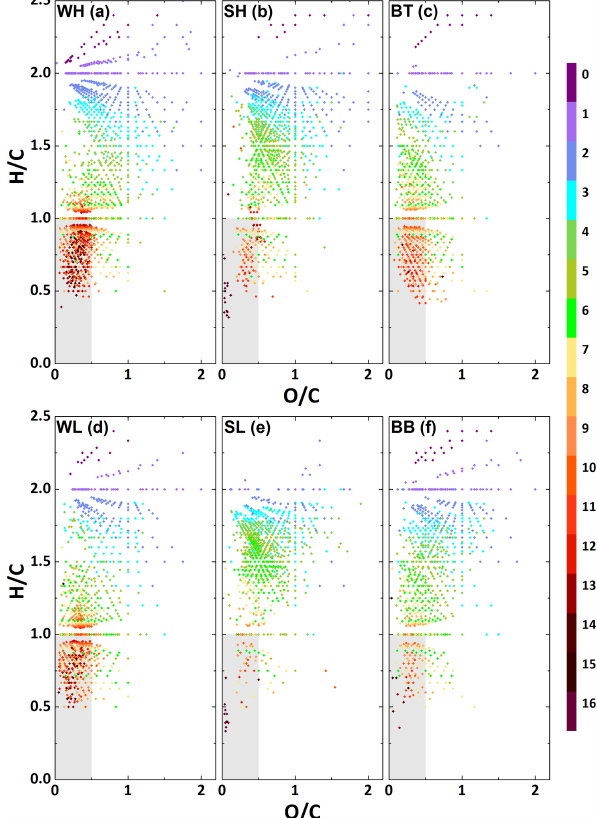
Figure 5. Van Krevelen plot for the WH, WL, SH, SL, BT and BB sample sets. Colour indicates the double bond equivalent (DBE), calculated under the assumption that sulfur is bivalent. The aromatic region is shaded in